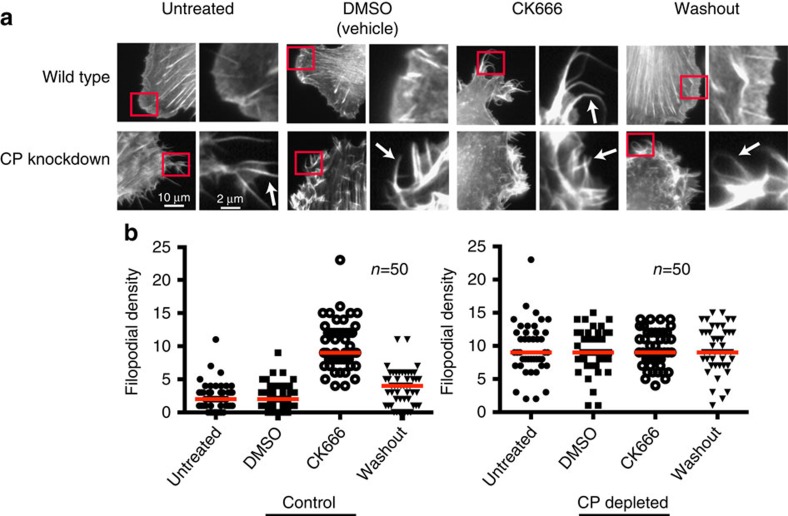
Effects of inhibition of Arp2/3 complex resemble loss of CP function.a) Cells were treated with the Arp2/3 complex inhibitor CK-666 in dimethyl sulfoxide (DMSO) for 3 h, then stained with fluorescent phalloidin. Negative controls included no treatment and vehicle (DMSO). In the washout sample, CK-666 was removed by washing with growth media, five times over 30 min. As a control, the inactive compound CK-689 produced no effect. Upper row: control cells. Lower row: cells treated with lentivirus-expressing CP shRNA targeting the CP β-subunit. Arrows indicate filopodia. Representative images from 20 cells are shown. (b) Quantification of normal lamellipodia (black) and increased filopodia (grey). The y axis is the number of cells; n=50.